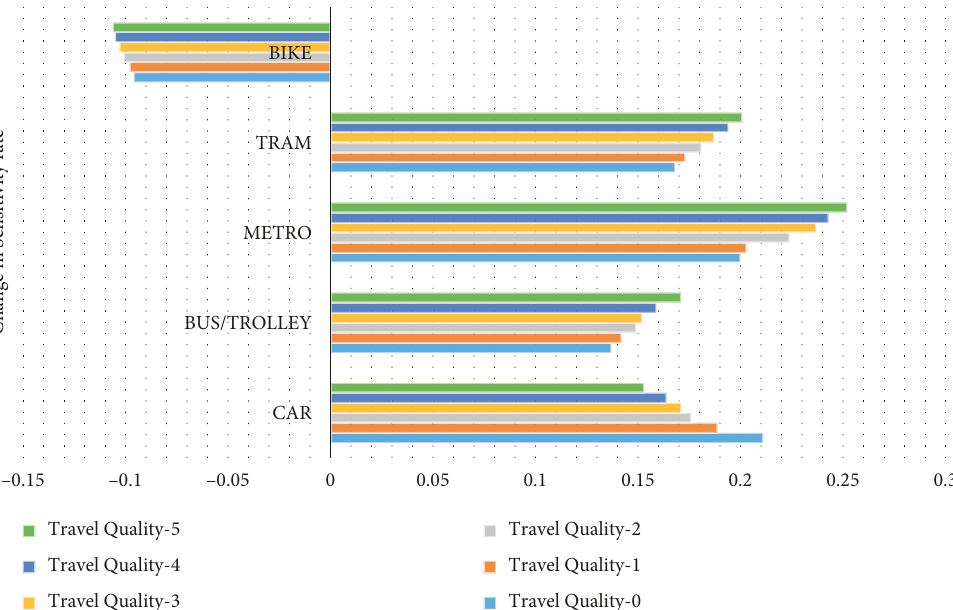
Figure 7: The values of the coefficients based on the changes in travel quality.